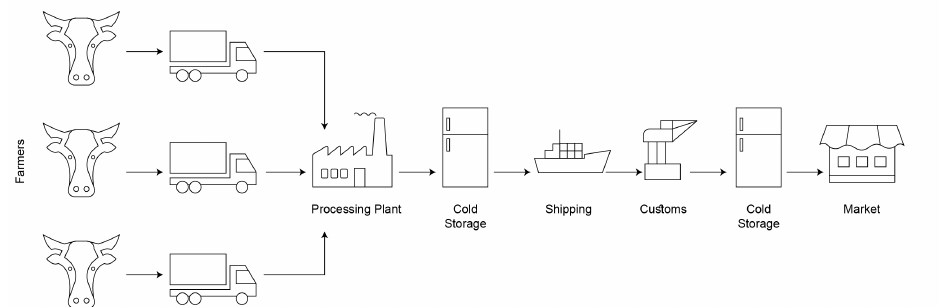
Figure 5. The overview of the beef supply chain.